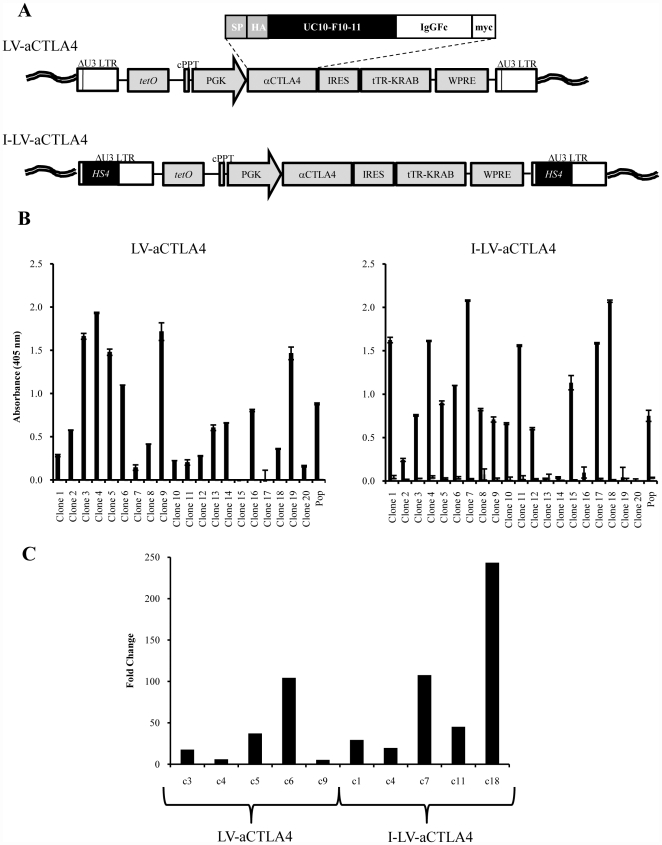
Lentivirus vectors expressing anti-CTLA4.
A) Structure of integrated provirus genomes. The vectors contain the gene for the monoclonal antibody 4F10 (ATCC: UC10-4F10-11) specific to mouse CTLA4. The anti-CTLA4 gene contains an immunoglobulin Vκ signal peptide, an HA epitope, the anti–CTLA4 scFv, the hinge, CH2 and CH3 domains of human IgG1, and a myc epitope. The anti-CTLA4 gene is under the control of a tTR-KRAB system [18]. tRT-KRAB bound to tet-operator sequences represses promoters in the vicinity of 3-4 kb. Addition of Dox releases this repression. The vector also contains a central polypurine tract (cPPT) and a woodchuck hepatitis virus post-transcriptional regulatory element (WPRC). In the insulated vector version (I-LV-aCTLA4), a 0.4 kb cHS4 insulator element [43] is inserted into the 398 bp U3 promoter/enhancer deletion (U3Δ). Upon proviral integration into host genome, the U3 region containing the cHS4 is copied over to the 5′ LTR. B) Evaluation of anti-CTLA4 expression on protein level for clones derived after transduction of MMC cells with LV-aCTLA4 (upper panel) or I-LV-aCTLA4 (lower panel). Solid bars: Dox induced expression. Clones were treated with Dox and 24 h later anti-CTLA4 was measured by ELISA in culture supernatants. Empty bars (to the right side of solid bars): non-induced expression levels: supernatant from clones w/o Dox treatment were analyzed by ELISA. (Note, that these bars are not visible for LV-aCTLA4). Anti-CTLA4 levels in the corresponding populations of transduced cells (Pop) are shown on the right. C) Fold change of anti-CTLA4 mRNA levels after culture with or without doxycycline for 24 h measured. Clones that expressed the highest levels of anti-CTLA4 protein were included in this analysis. mRNA was isolated and subjected to qRT-PCR for GAPDH and anti-CTLA4 mRNA. Shown is the fold difference of GAPDH normalized anti-CTLA4 mRNA levels with and without Dox induction. Standard deviation was less than 10%.